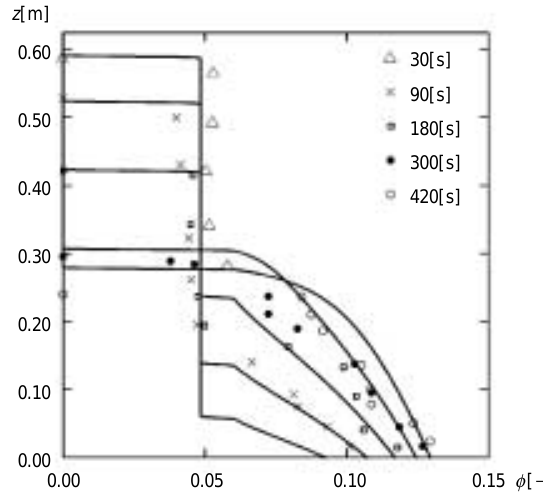
Comparison of concentration profiles measured by Bergström (1992) with numerical simulation of the set- tling experiment, after Garrido et al.